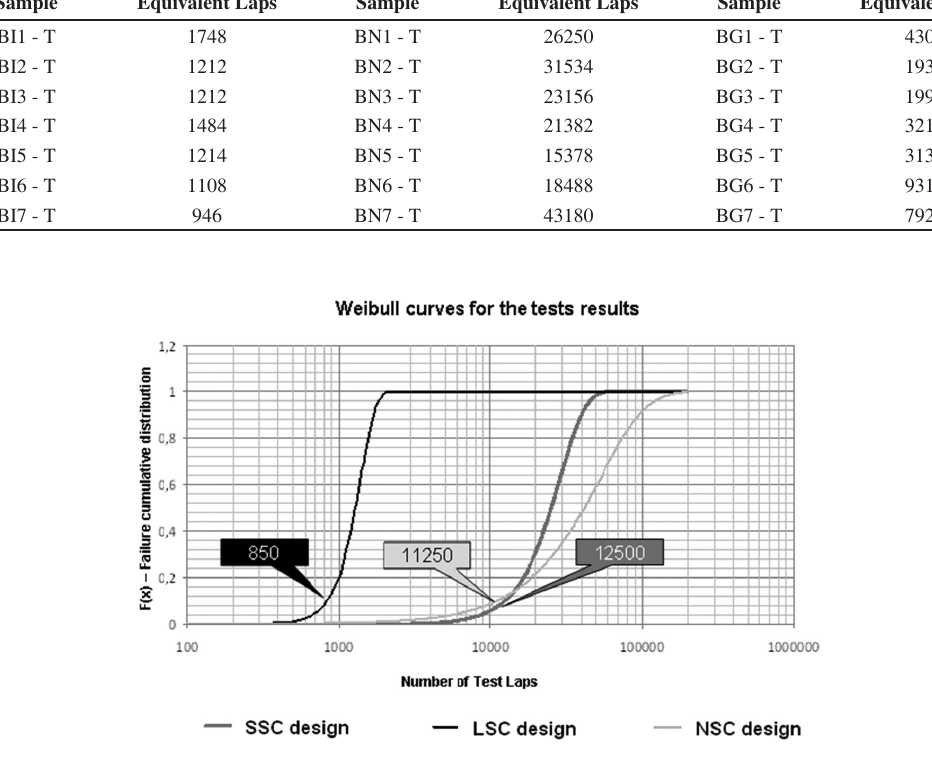
Figure 10. Weibull curves showing the expected B10 life for each